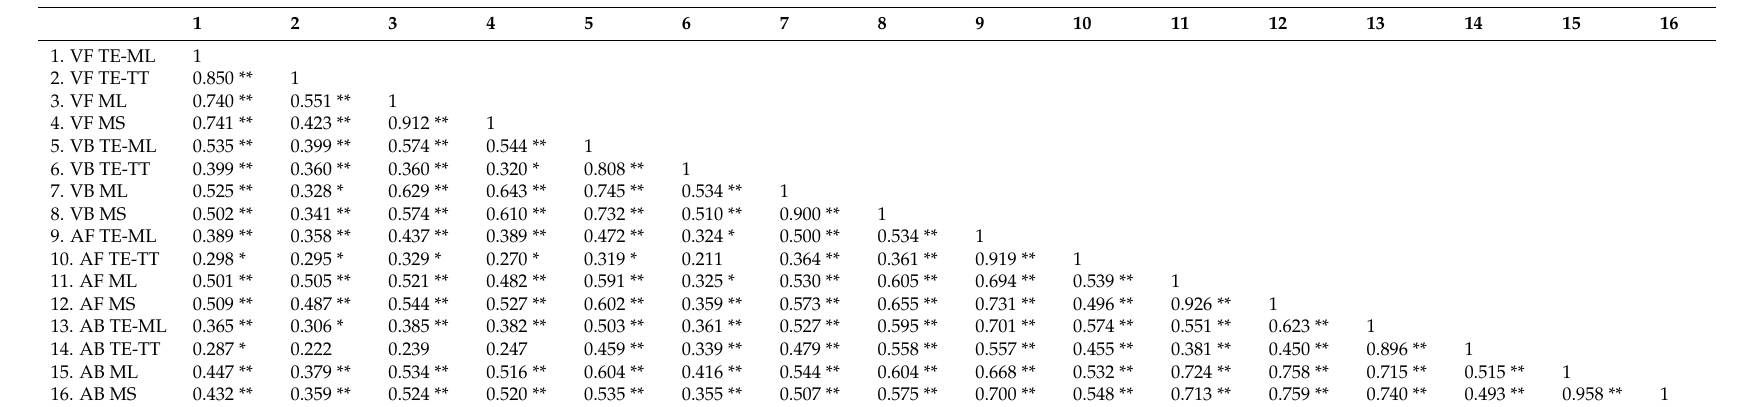
Table 6. Correlation between dependent variables from digit span